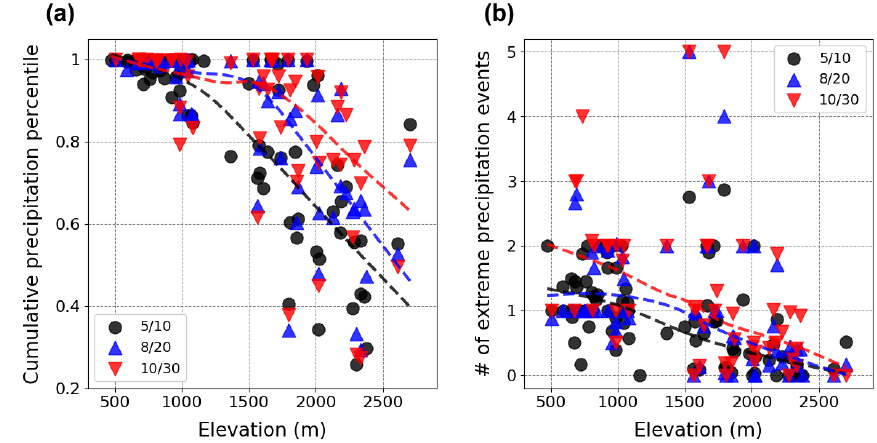
Figure 9. (a) Average cumulative precipitation percentile during and 10d prior to persistent high-discharge periods as a function of mean catchment elevation. Black circles (respectively blue triangles, red triangles) correspond to events characterized by at least 5d (respec- tively 8, 10d) within a 10d (respectively 20, 30d) window with discharge above its 99th percentile. (b) Same as (a) , but for the number of extreme precipitation